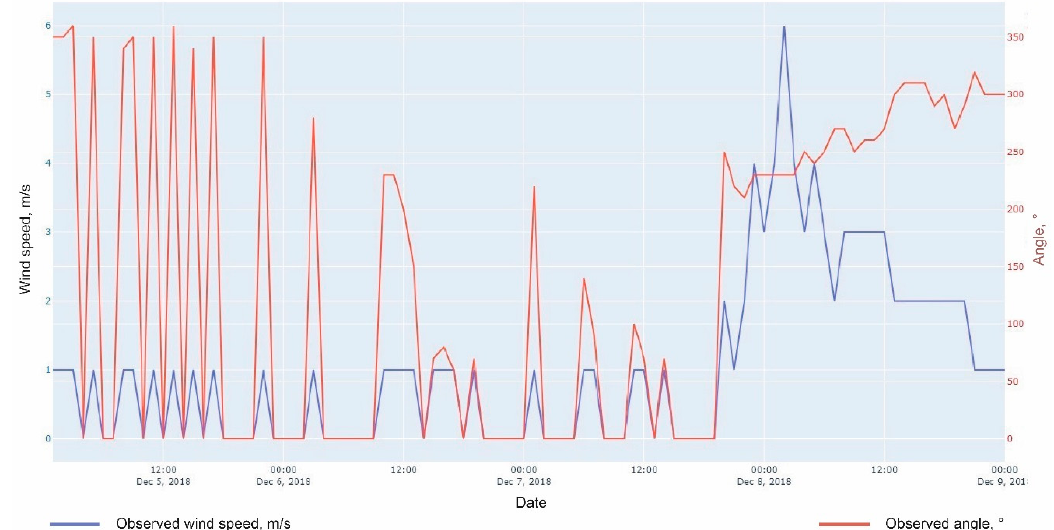
Figure 6. Wind speeds and directions by the data from meteorological station 29572 (Krasnoyarsk—downtown).